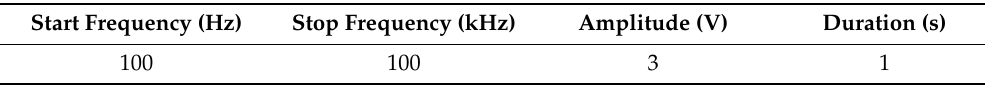
Table 5. Detailed properties of emitted signal.